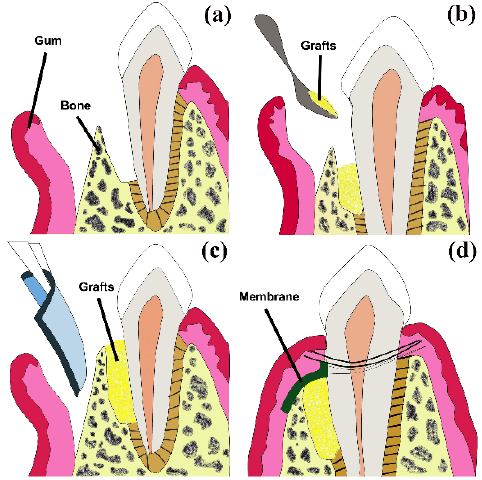
Figure 1. A schematic diagram illustrating the treatment of periodontal defects using a combination of bone grafts and guided bone regeneration techniques. ( a , b ) The use of bone grafts to replace missing bone. The grafts may stimulate bone growth, and the new bone will fill the defect. ( c , d ) A barrier membrane was placed between the gum and the bone defect area to prevent rapid proliferation of epithelial cells or fibroblasts while allowing enough space for periodontal tissue regeneration. Reproduced with permission from [6]. Copyright 2010,